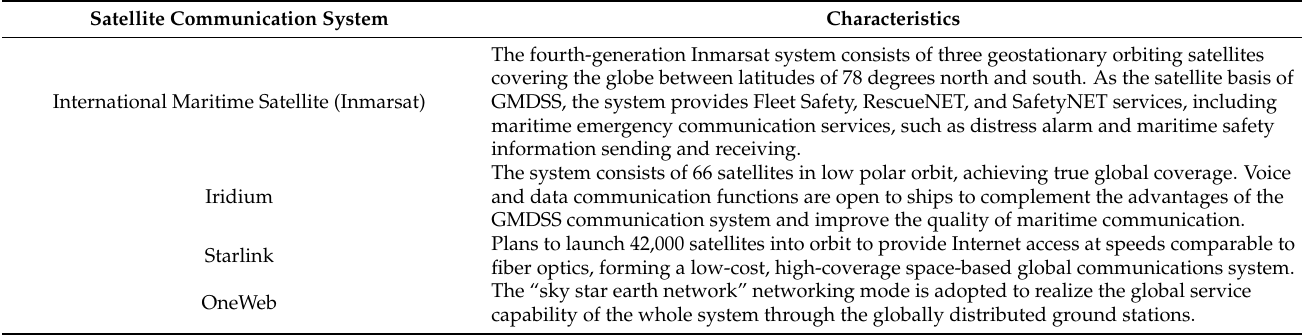
Table 4. Representative foreign satellite communication systems.